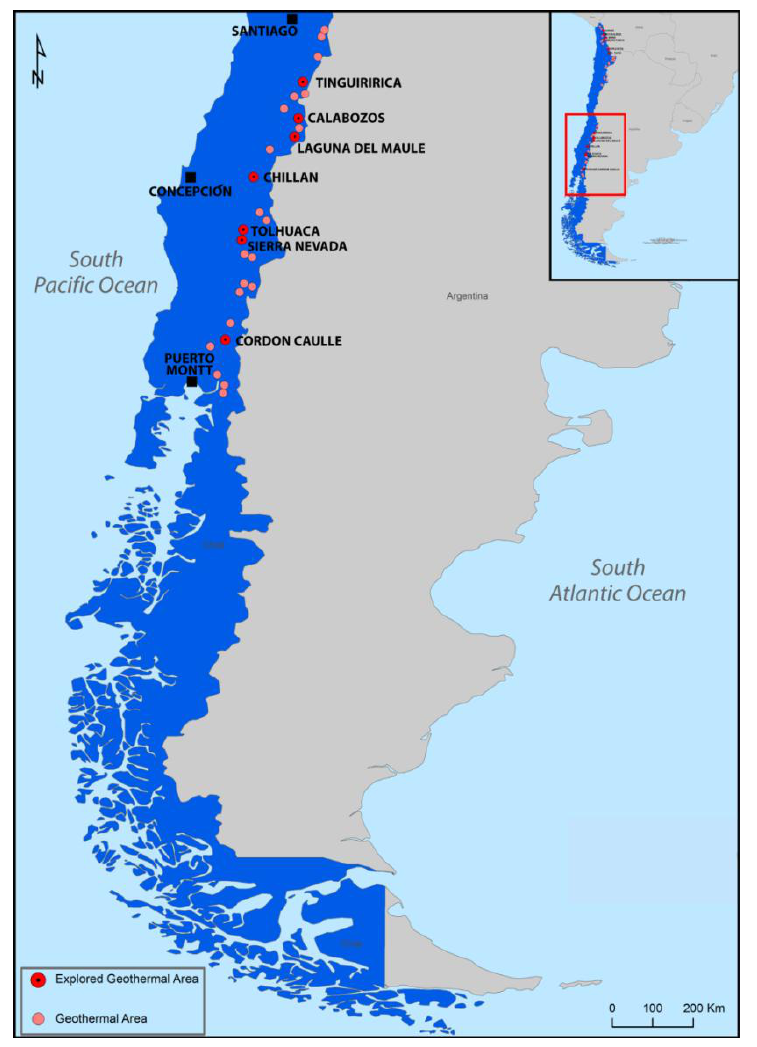
Figure 4. Geothermal areas of southern